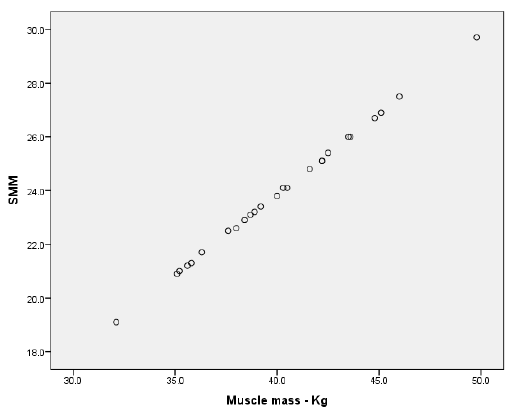
Figure 10. Correlation between SMM and muscle mass (kg) for the group of girls without ID.